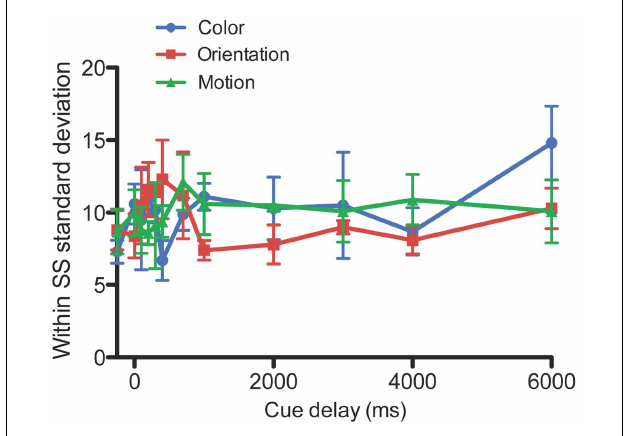
FIGURE 3 |Within subject standard deviation for color, orientation, and motion. The standard deviation across the five blocks for each individual subject, averaged across the four subjects. Error bars denote standard errors of the mean.